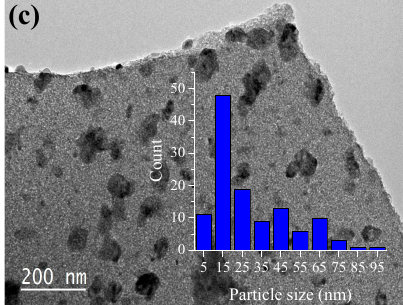
Figure 5. TEM images (inset, nanoparticle size distribution) of ( a ) 10Ni–Al, ( b ) 10Co–Al and ( c ) 10Cu–Al calcined samples.